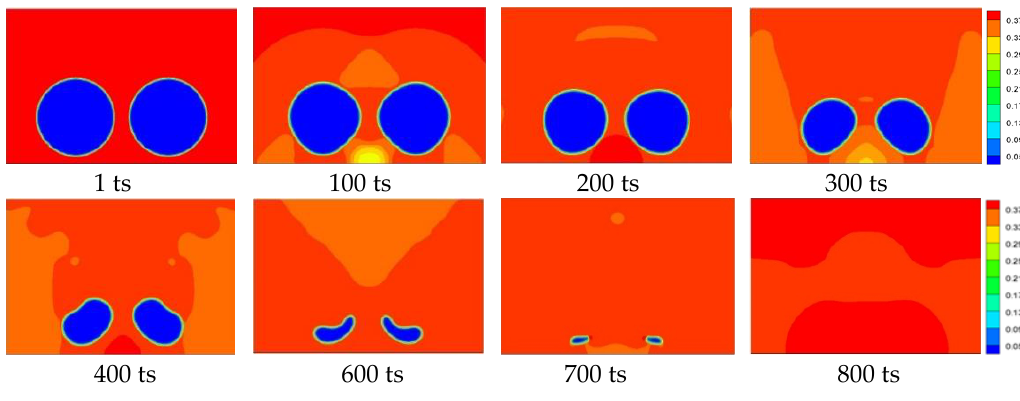
Figure 9. Density field of cavitation bubble collapse.